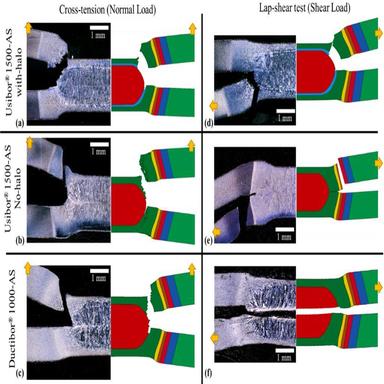
Predicted versus observed cross-section of spot welds showing the location of failure under (a), (b) and (c) normal loading, and (d), (e), and (f) shear loading for different spot weld conditions.